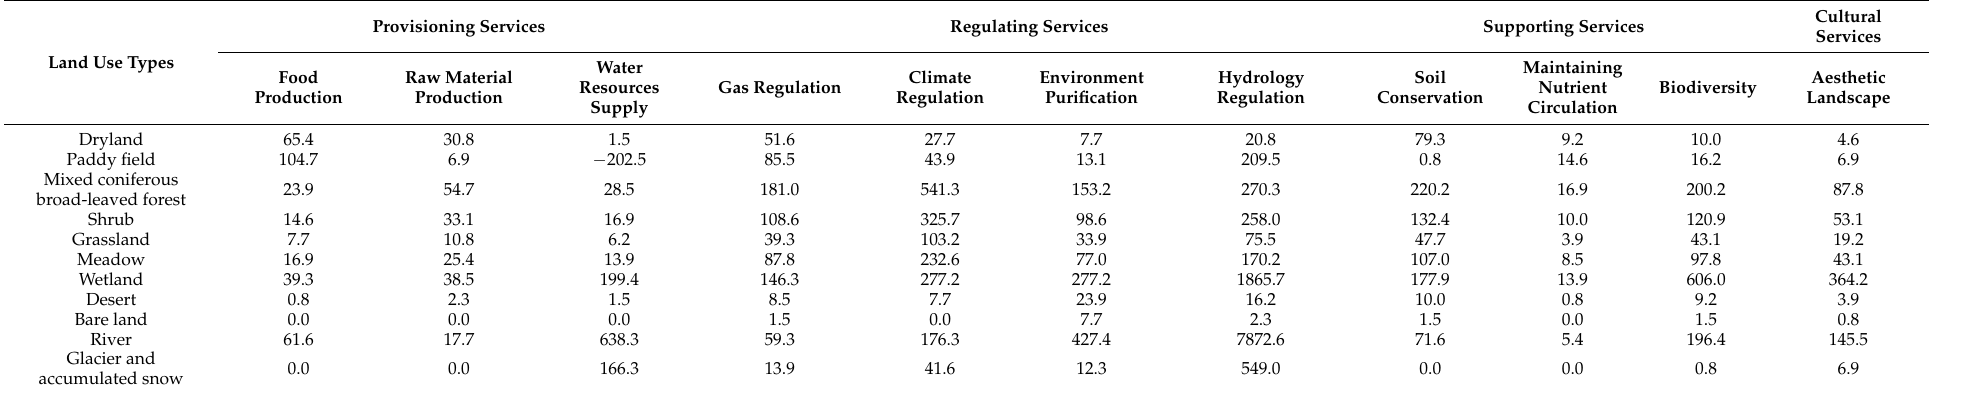
Table 3. Ecosystem service value per unit area of land use types in the ORTTR (USD/hm 2